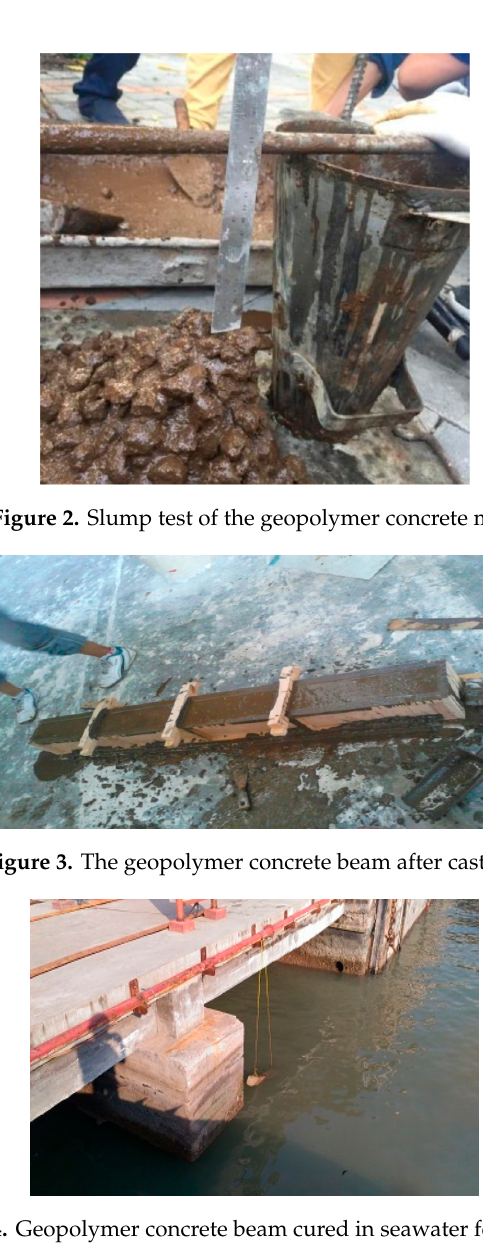
Table 3. Chemical content analysis of sea water.